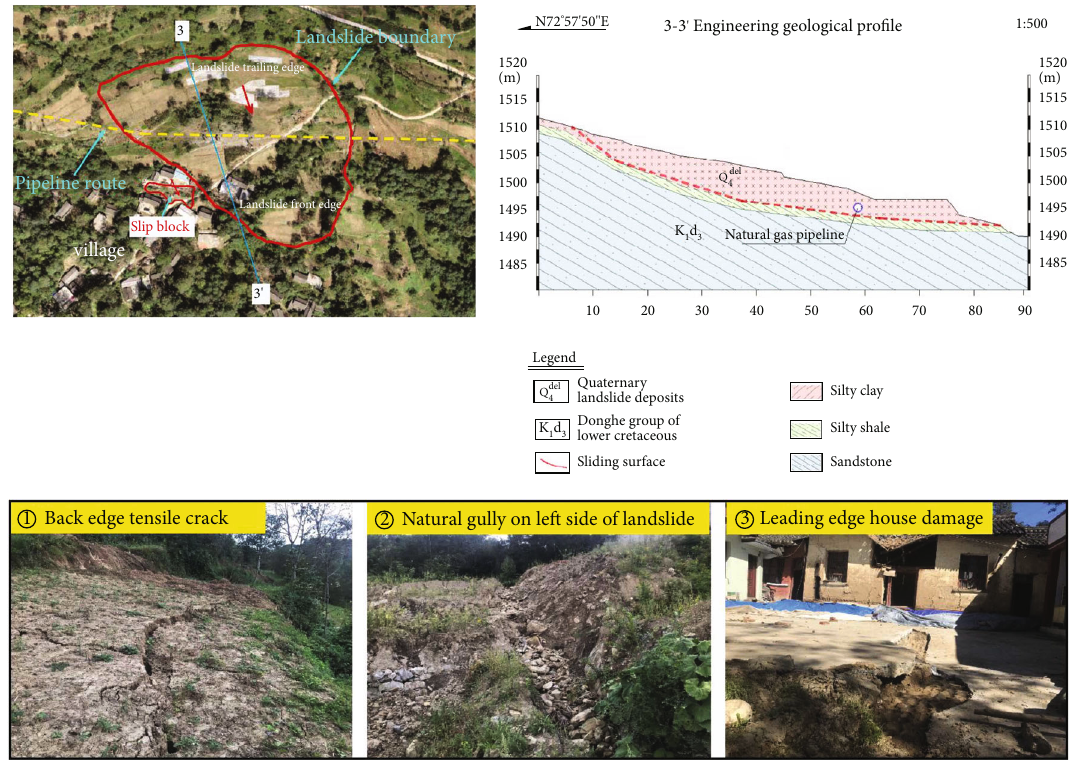
Figure 2: Geological characteristics of pipe-landslide area. Table 1: Similarity relation and similarity